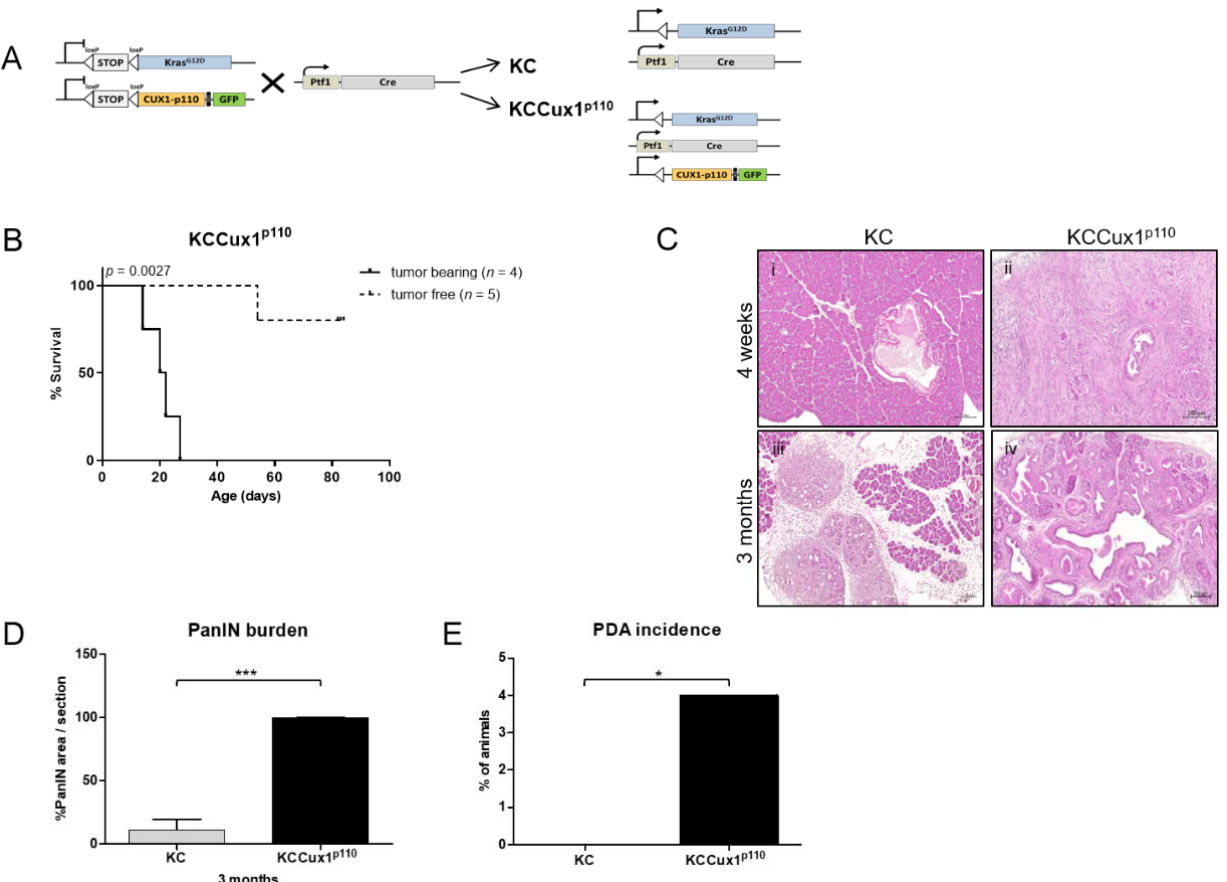
Figure 3. Generation and validation of KCCux1 p110 mice. ( A ) Breeding scheme for the generation of Kras LSL-G12D/+ ; Ptf1a Cre/+ ; Cux1 LSL-p110/+ mice. Kras LSL-G12D/+ ; Cux1 LSL-p110/LSL-p110 mice were mated with Ptf1a Cre/+ mice to generate Kras LSL-G12D/+ ; Ptf1a Cre/+ and Kras LSL-G12D/+ ; Ptf1a Cre/+ ; Cux1 LSL-p110/+ animals. ( B ) Survival of tumor-bearing ( n = 4) and tumor-free ( n = 5) KCCux1 p110 mice. Kaplan–Meier curves showed a median survival for tumor-bearing mice of 21 days and for tumor-free mice of 83 days with significant difference by log-rank test, p = 0.0027. ( C ) Representative H&E stainings of 4-week-old (left) KC (i) and tumor-bearing KCCux1 p110 (ii) and 3-month-old (right) KC (iii) and tumor-free mPanIN-bearing KCCux1 p110 (iv) mice. Scale bar, 100 µ m. ( D ) Analysis of PanIN burden in 3-month-old KC (grey; n = 9) and KCCux1p110 (black; n = 5) mice. *** p ≤ 0.0001 by t -test. Data shown as mean ± SD. ( E ) Percentage of tumor-bearing KC and KCCux1p110 mice. In the KC cohort, 0 of 10 mice, and in the KCCux1p110 cohort (black bar), 4 of 9 mice showed a PDAC. * p ≤ 0.02 by Fisher’s exact